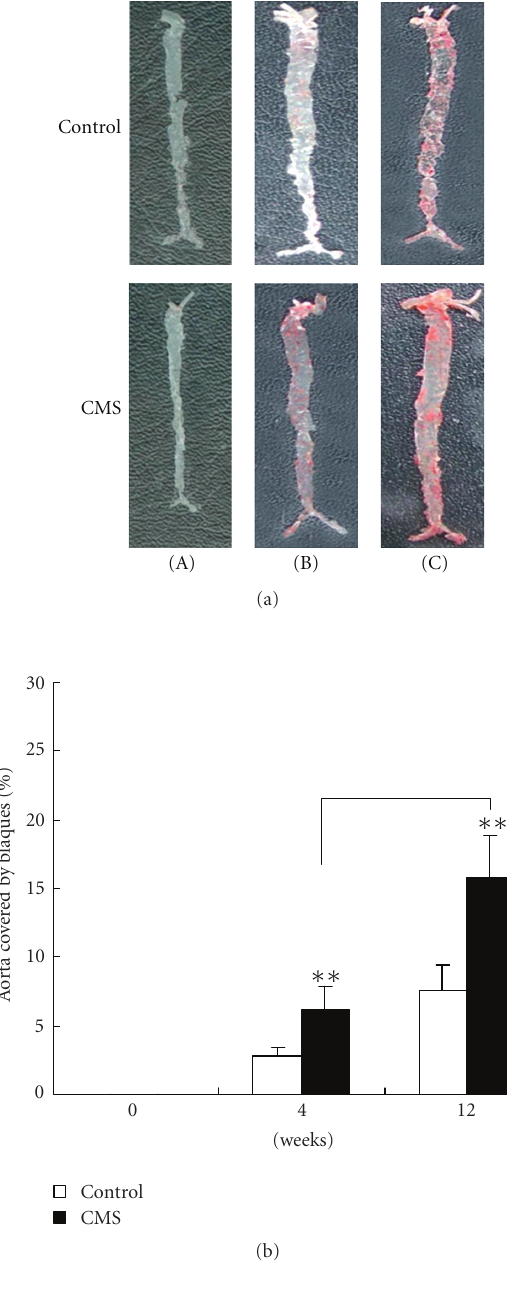
Figure 4: CMS markedly increases the extent of aortic atheroscle- rosis development in apoE-/- mice. (A)–(C) Representative pho- tographs of aortic sinuses from control apoE-/- (top) and CMS (bottom) apoE-/- mice. (a) Aortas of apoE-/- mice subjected to CMS or normal condition (control) for 0 week (A), 4 weeks (B), and 12 weeks (C) were isolated and stained for lipid deposition Soudan IV. Representative specimens from the two groups are shown. (b) Quantification of plaque areas in whole aortas in CMS and control apoE-/- mice stained for lipid deposition with Soudan IV. Each bar represents mean ± SEM ( n = 10 per group). Total plaque area in CMS mice was significantly increased compared with corresponding con- trol mice. ∗∗ P < . 01, ∗∗∗ P < . 001 versus the control